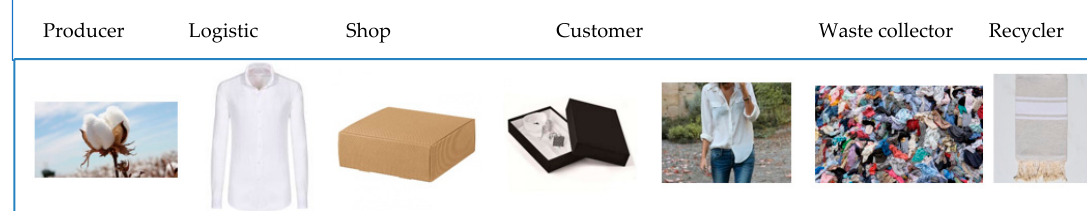
Figure 6. Polymorphic data example .